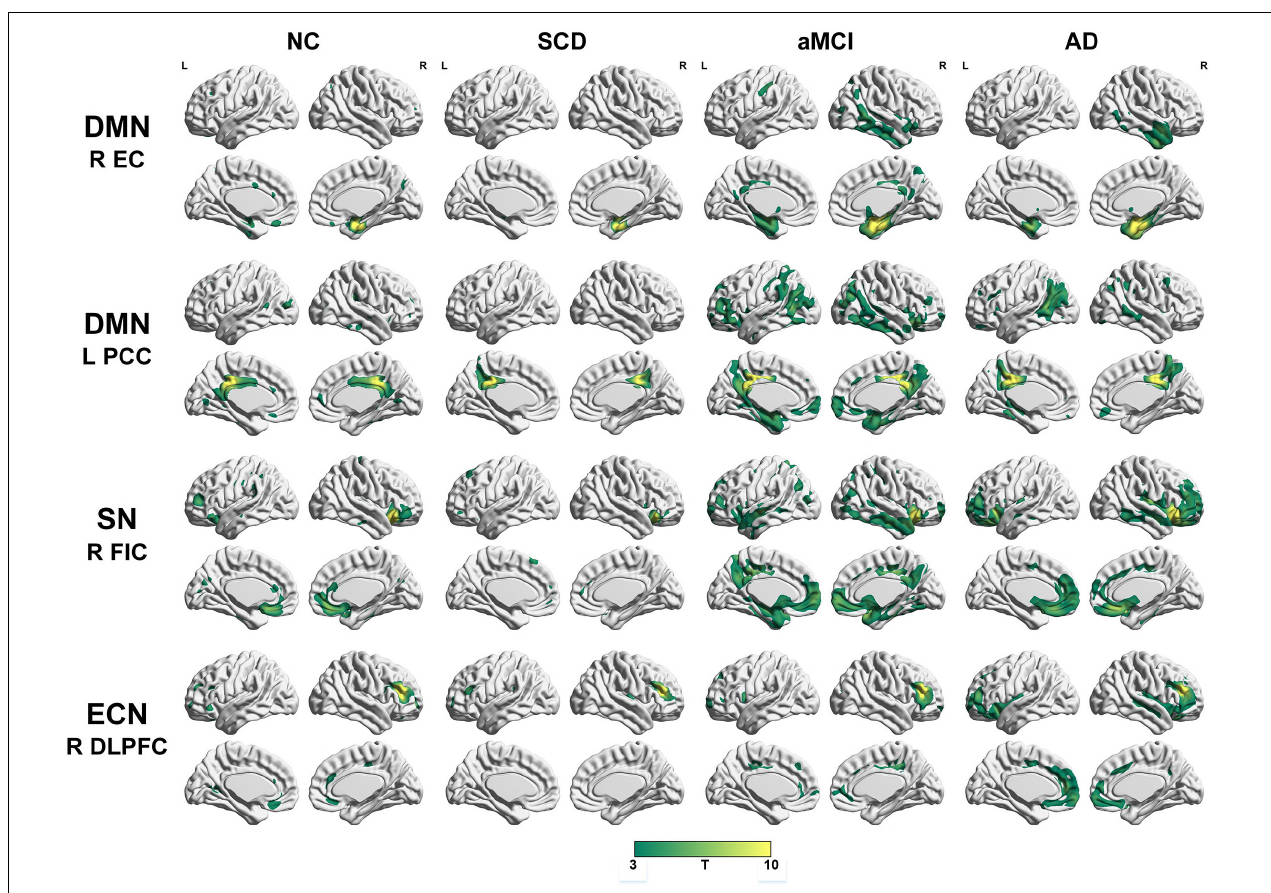
FIGURE 1 | Structural covariance networks seeding from the default mode network, salience network, and executive control network within groups. T-statistic maps, p < 0.05, corrected by false discovery rate (FDR) with cluster size larger than 100 voxels. L, left; R, right; EC, entorhinal cortex; PCC, posterior cingulate cortex; DLPFC, dorsolateral prefrontal cortex; FIC, frontoinsular cortex; AD, Alzheimer’s disease; NC, normal control; aMCI, amnestic mild cognitive impairment; SCD, subjective cognitive decline.